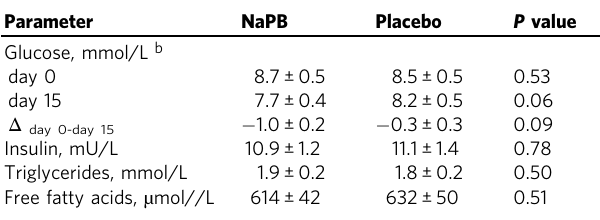
a n = 16. Data expressed as mean±SE. The intervention effect was analyzed using the paired student t -test. * P values < 0.05 NaPB vs. Placebo. Fasting blood samples were taken after 2 weeks (15 days) of NaPB treatment or placebo after an overnight fast. NaPB sodium phenylbutyrate, BCAA branched-chain amino acids. b n =